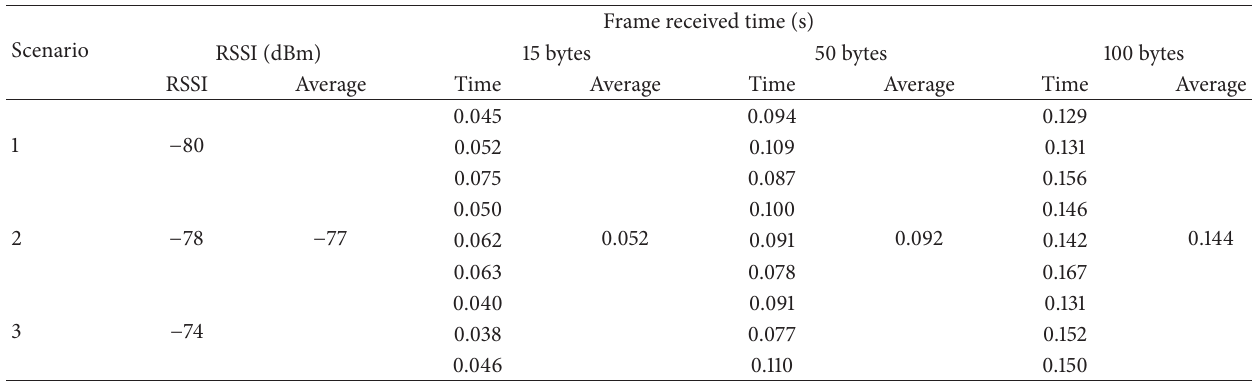
Table 4: Experimental results of Case 2